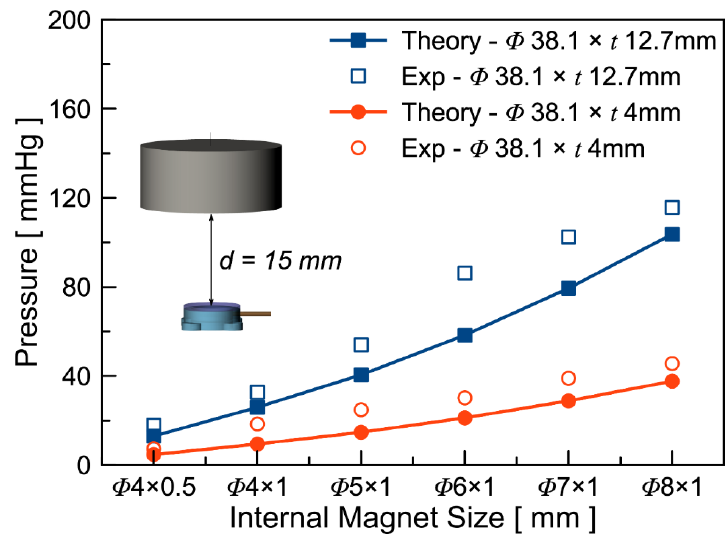
Figure 4. Theoretical and experimental results of the static pressure of various internal magnet sizes under an external magnetic field caused by two different external magnets. The distance between the bottom of the magnet and the top of the microfluidic pump is controlled at 15 mm.